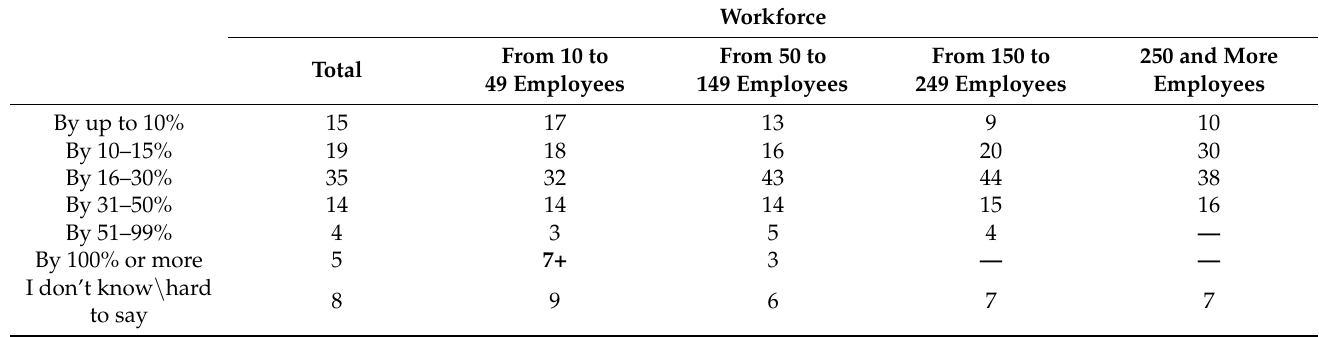
From 10 to 250 and More